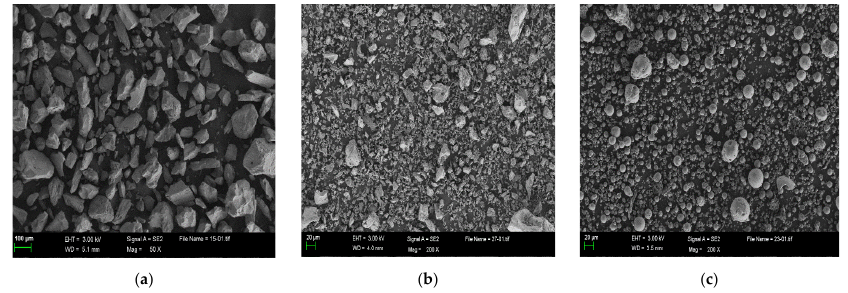
Figure 1. SEM image of ( a ) IOTs; ( b ) CP; and ( c ) FA.